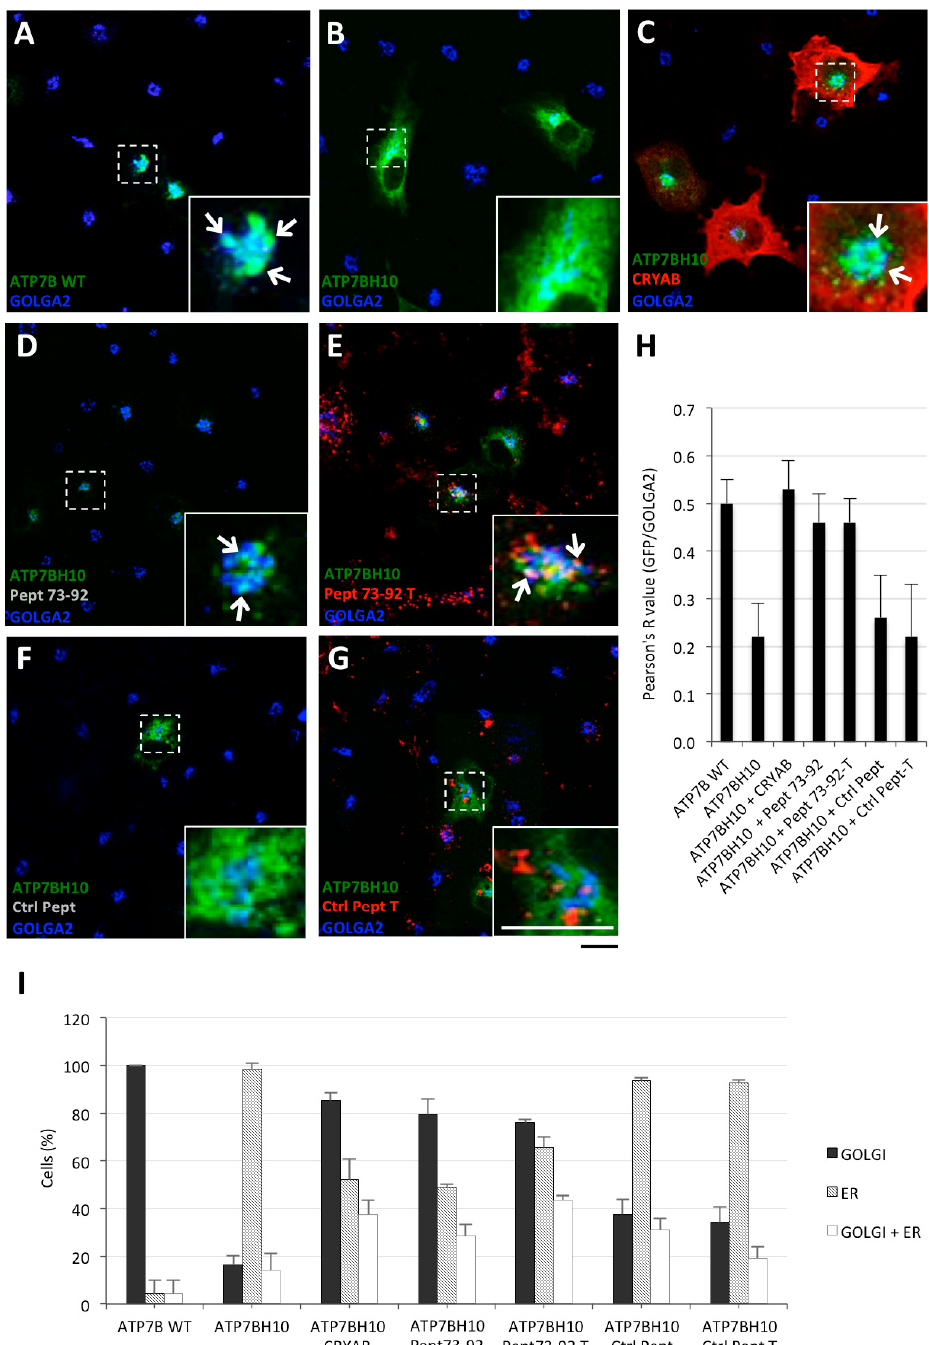
Figure 2. Pept 73–92 specifically rescues Golgi localization of ATB7B-H1069Q. ( A – G ) immunofluorescence analysis of COS7 cells transfected to express GFP-tagged ATP7B or ATP7B-H1069Q alone, or co-transfected to express full-length HA-tagged CRYAB or incubated with TAMRA-tagged (T) or untagged Pept 73–92 or control peptide 1 (Ctrl Pept), as indicated in each panel. After fixation, the cells were processed for triple confocal immunofluorescence analysis to reveal the Golgi complex with the marker GOLGA2. White arrows as in Figure 1. Scale bar: 10 μ m; ( H ) colocalization analysis of GFP and GOLGA2 signals (means ± SD, n = 15 cells from three independent experiments). ( I ) Quantification of the percentage of cells exhibiting exhibiting ER, Golgi complex, and both ER and Golgi complex GFP staining (means ± SD, n = 25 cells from two independent experiments). Abbreviations as in Figure 1.